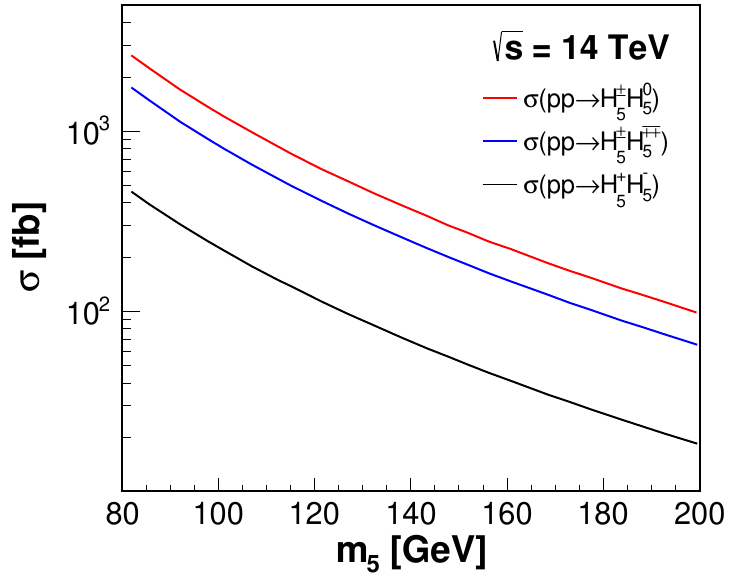
Figure 5 . Leading-order cross sections for the Drell-Yan production processes involving H (cid:6) another H 5 scalar, for pp collisions at a centre-of-mass energy of 14